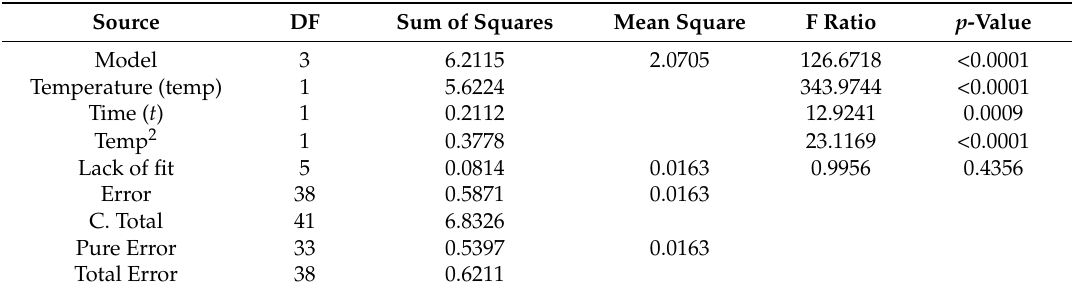
Figure 4. Effect of time (min) and temperature ( ◦ C) on trypsin inhibitor activity (TIA) of soymilk during conventional thermal treatment. Table 8. ANOVA for effect of time ( t ) and temperature (temp) on trypsin inhibitor activity for microwave processing.